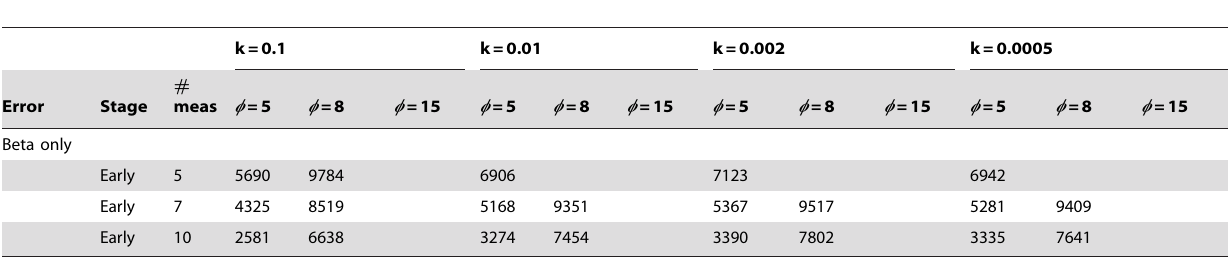
Table 2. Simulations for which ML estimation with beta errors (option 2) failed to converge for 10,000 out of 12,000 generated data